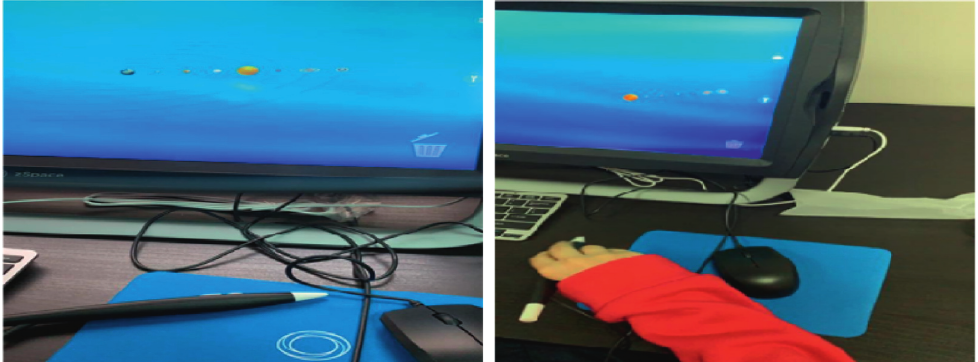
Figure 3: Solar system lesson through zSpace.